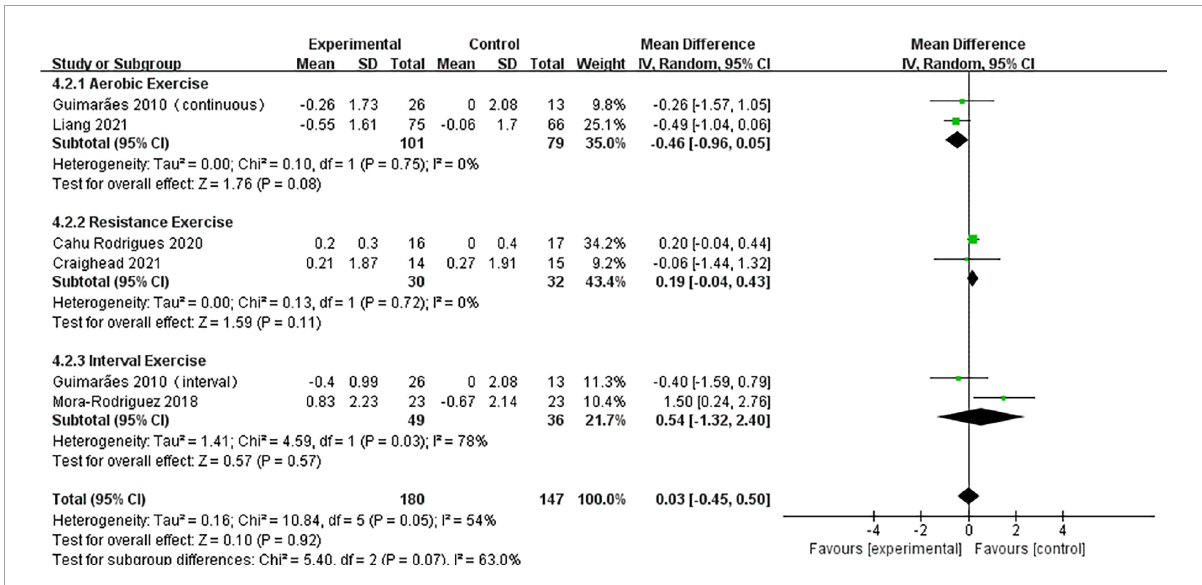
FIGURE6 Forest plot of postintervention PWV-value comparison between exercise and control groups. SD, standard deviation; Std, standardized; IV, inverse variance; CI, confidence interval.